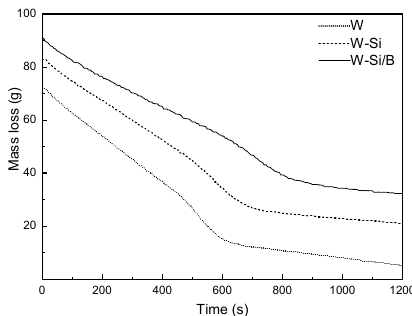
Figure 4. Mass loss of wood during the cone calorimetric test.